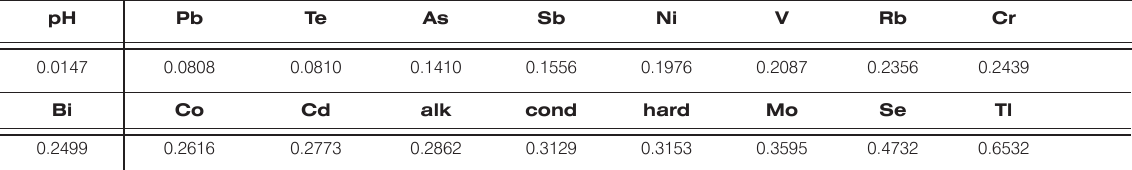
Table 5. The Gini coefficients for all